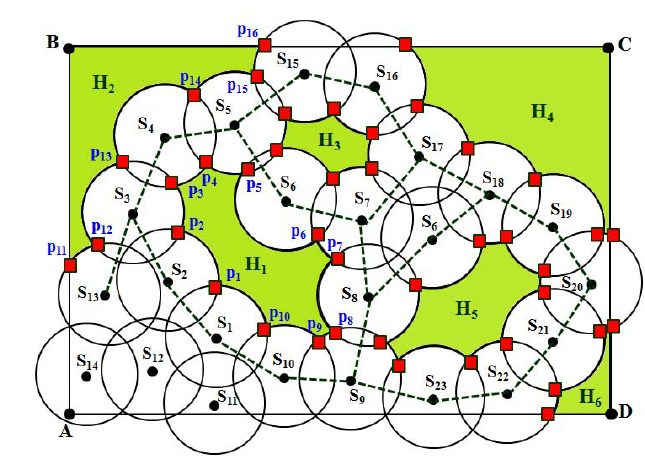
Figure 4. Example of the calculating of CIP and